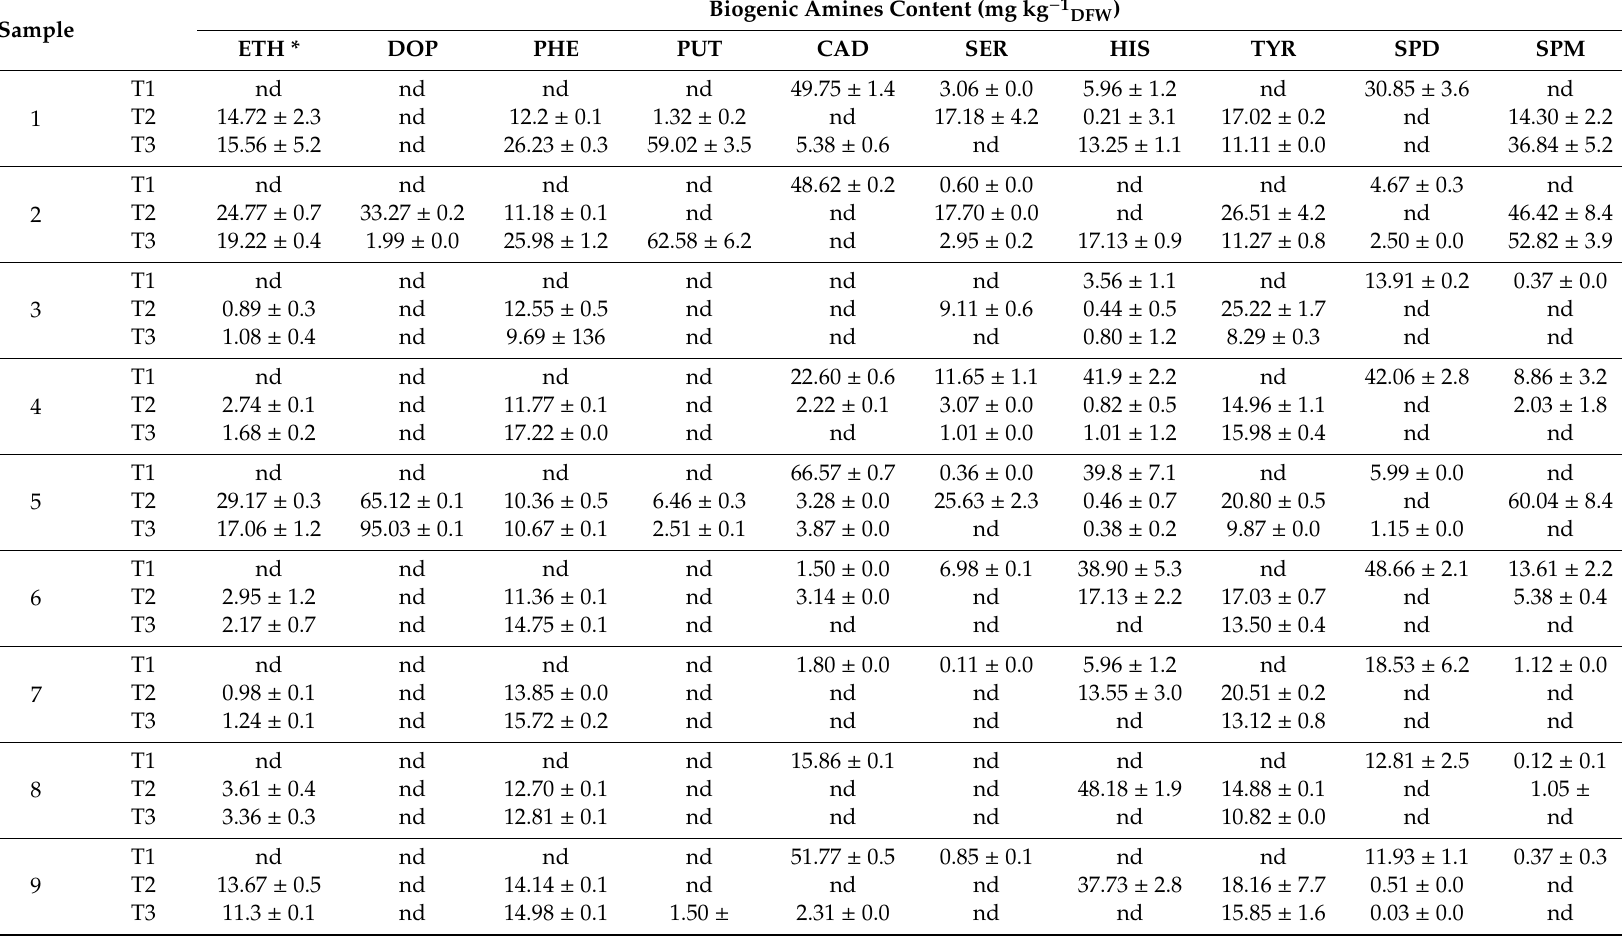
Table 3. Biogenic amines (mg kg − 1 DFW ) in Criollo cocoa bean samples after fermentation and drying (T1) and after roasting (T2, 120 ◦ C for 22 min; T3, 135 ◦ C for 15